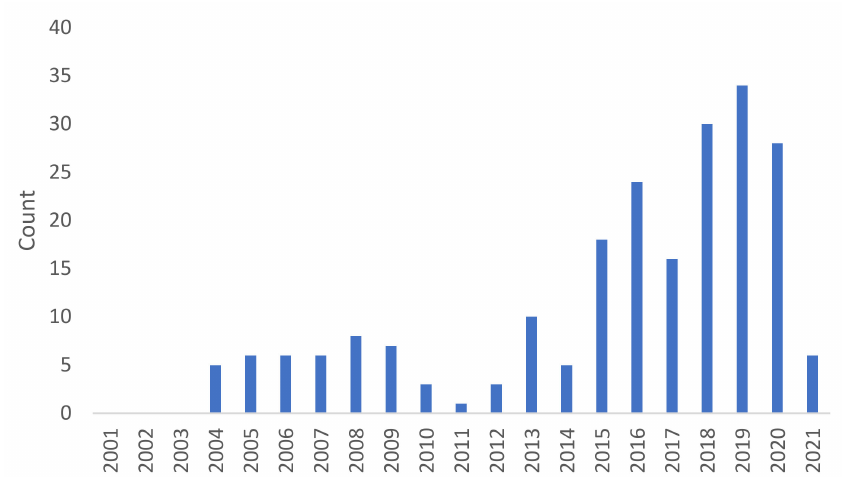
Figure 1. Publication trend since 2001 for kinase inhibitors and brain metastases from breast cancer, lung cancer and